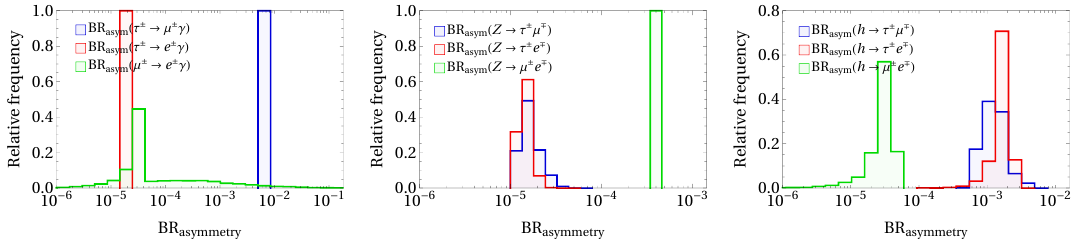
Figure 12 . Histograms of the asymmetries between the exact nine branching ratios and their approximate expressions in eqs. (3.5), (3.7), and